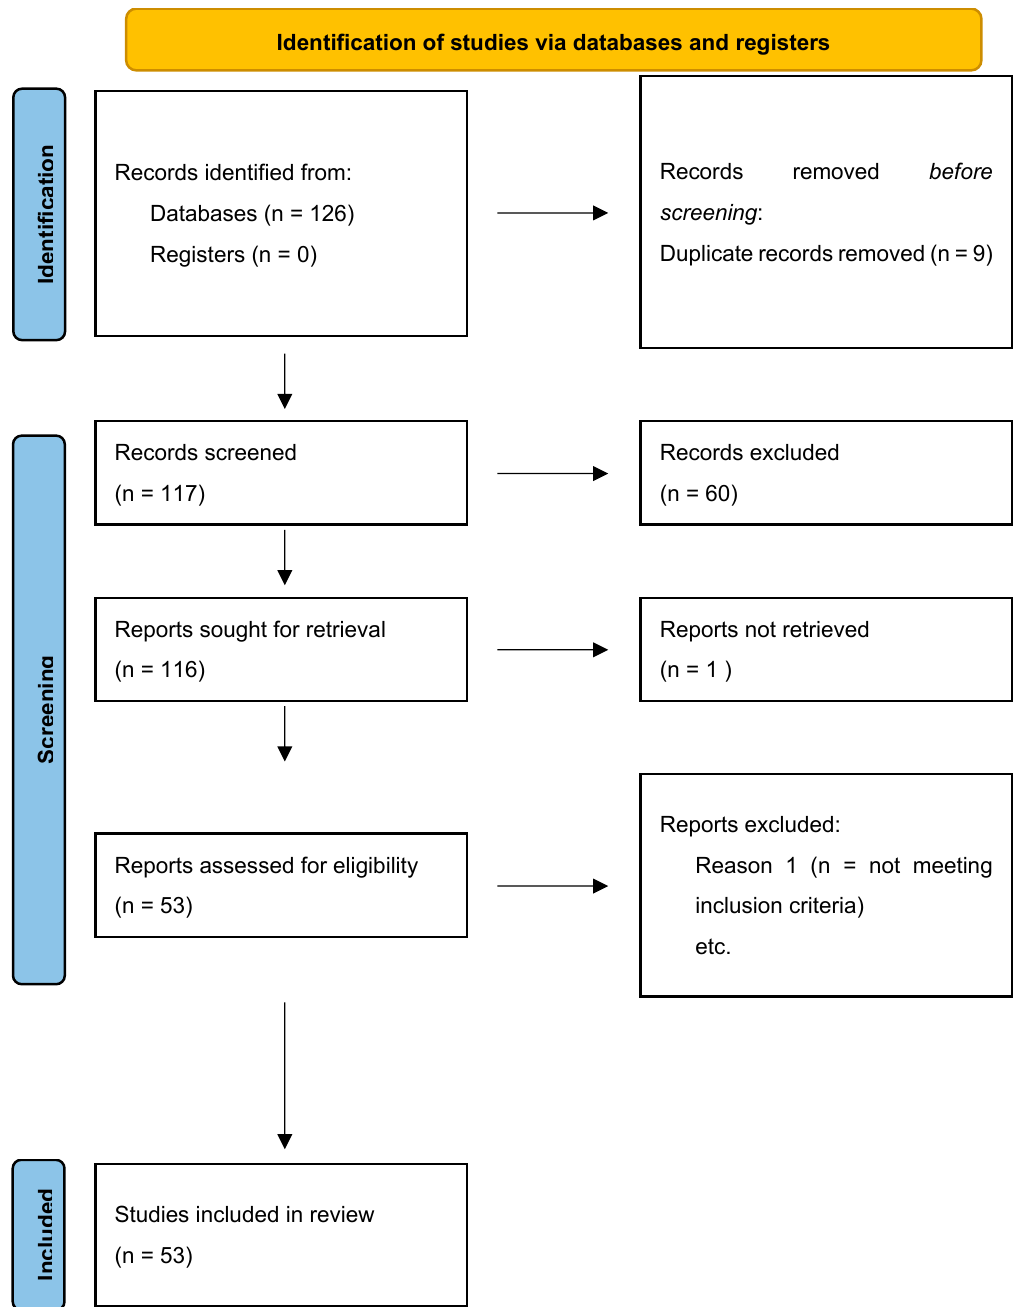
Figure 1. PRISMA flowchart used in review about PRAME.